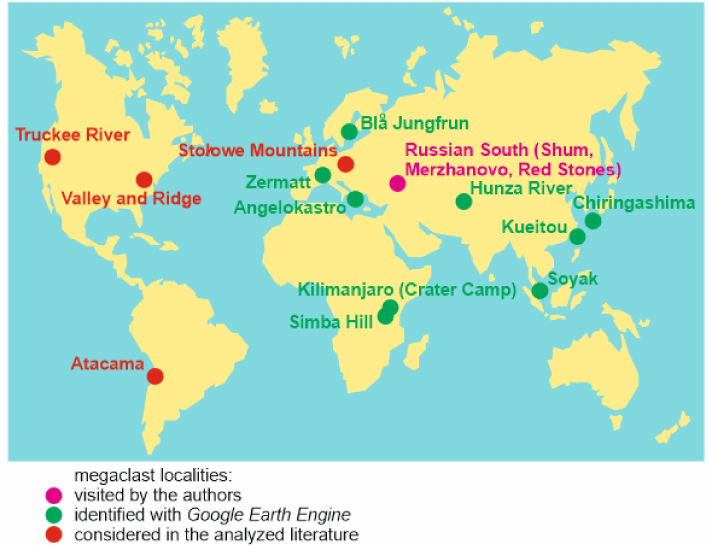
Figure 2. Megaclast localities considered in the present